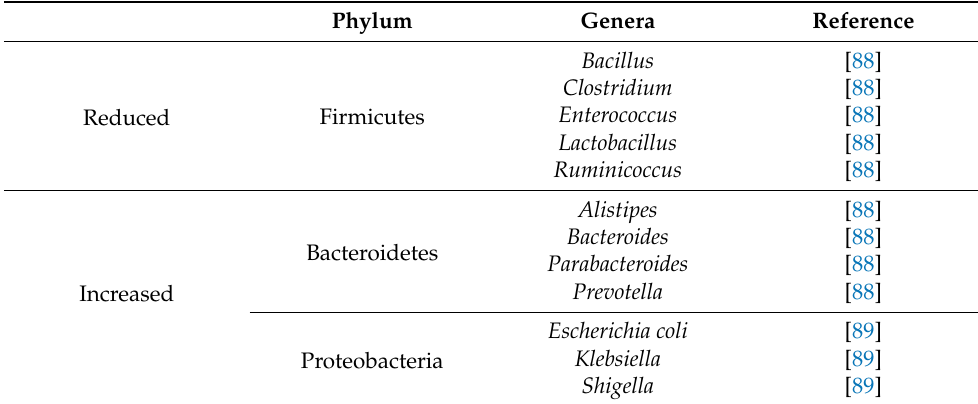
Table 3. List of altered bacteria in inflammatory bowel disease.